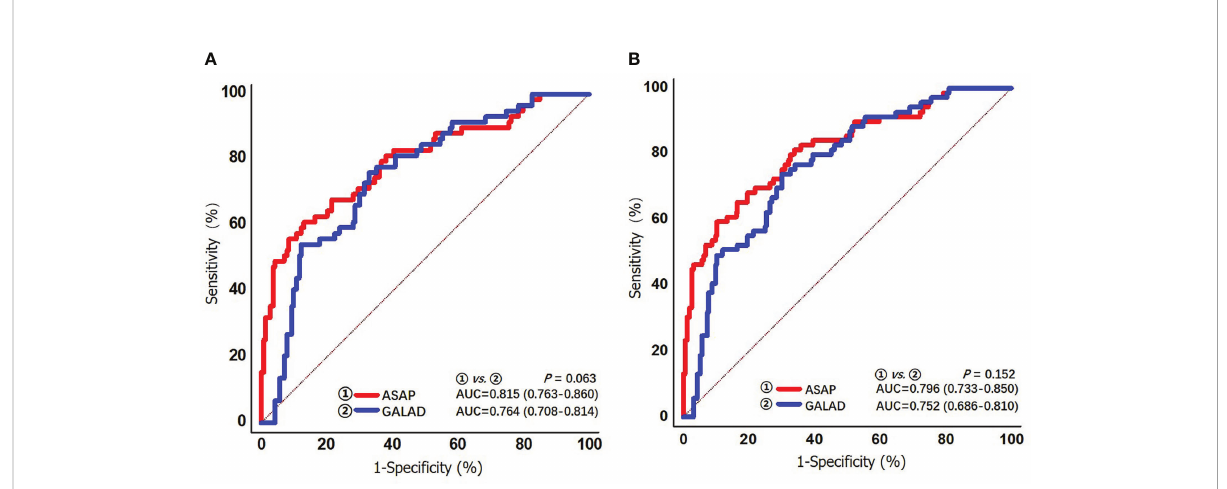
FIGURE 5 ROC curves of the ASAP score and the GALAD score for detecting AFP-negative HCV-HCC (AFP < 20 ng/mL) in the overall group (A) and the cirrhosis subgroup (B)